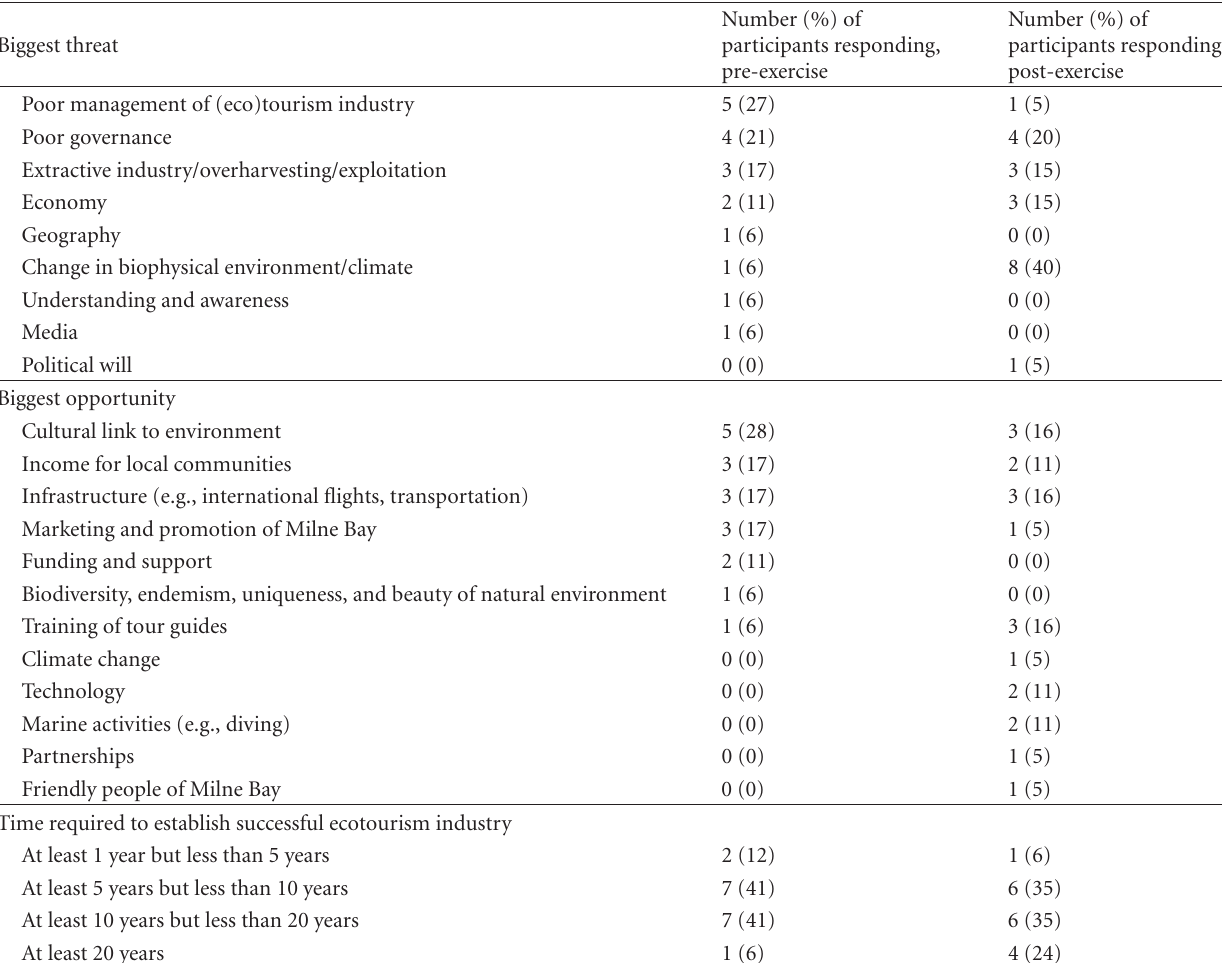
Table 2: Perceptions of biggest threat to Milne Bay ecotourism, biggest opportunity for Milne Bay ecotourism and time required to establish a successful ecotourism industry in Milne Bay, pre- and post-scenario